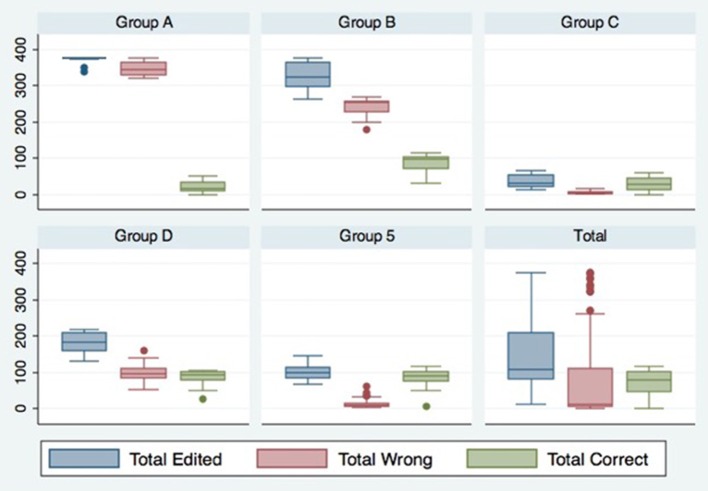
K mean cluster analysis.